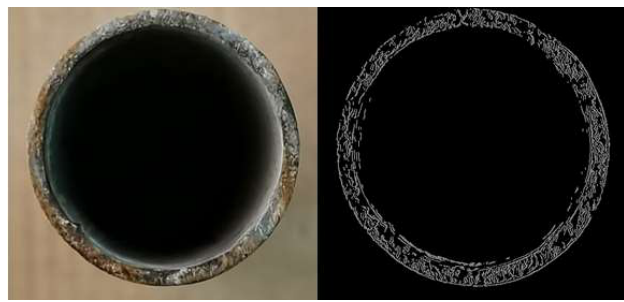
Figure 1. Canny Algorithm detection effect.